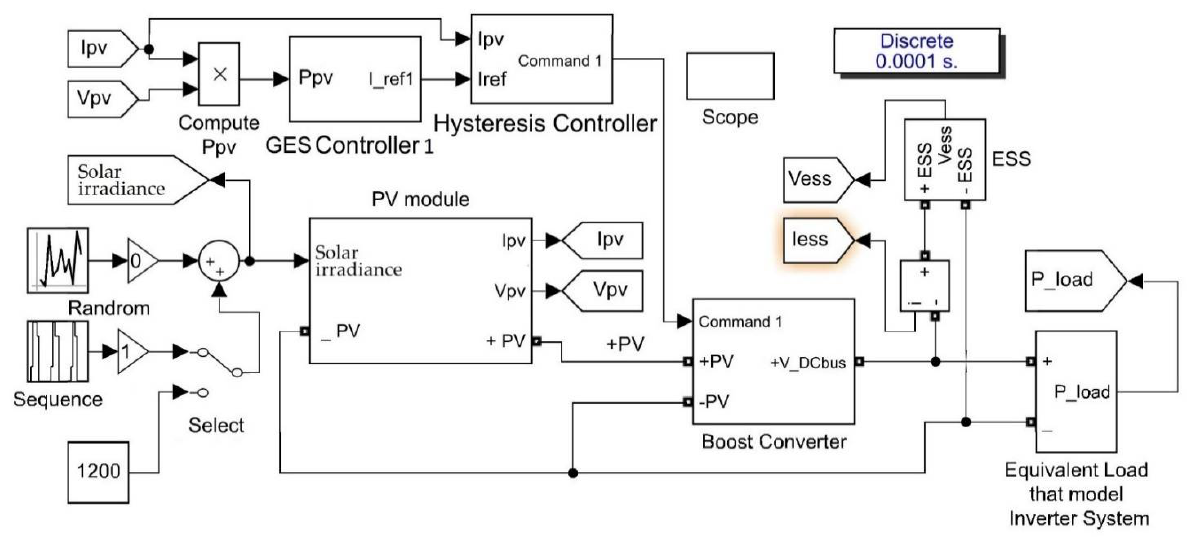
Figure 4. PV/ESS system diagram.